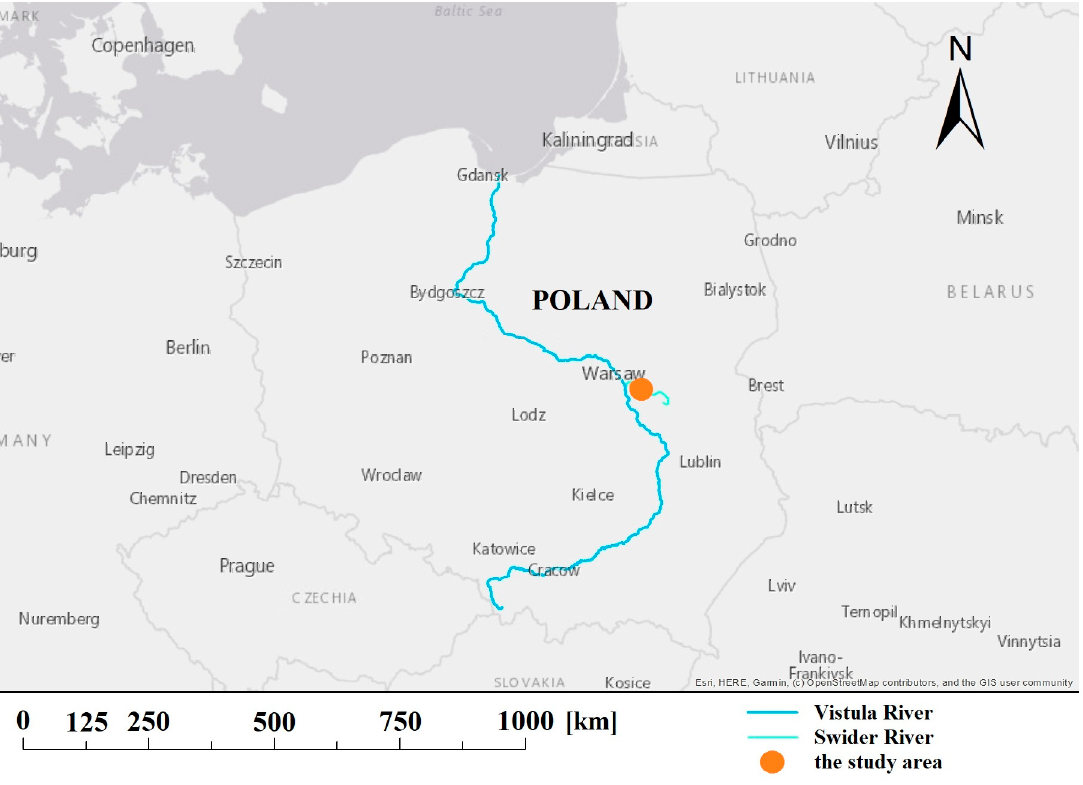
Figure 1. Location of the Swider River in Poland.